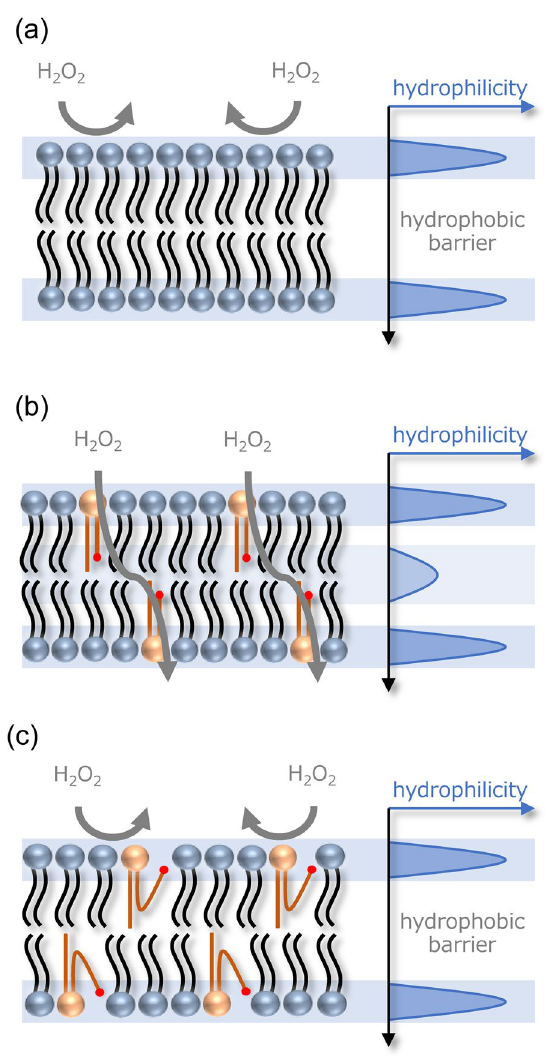
Figure 3. Schematic illustration of H 2 O 2 permeation through DOPC/POVPC bilayer under different molecular configurations. ( a ) DOPC bilayer without POVPC has a high hydrophobic barrier at the alkyl chain region, which inhibits the permeation of H 2 O 2 . ( b ) POVPC at 5 mol % forms a molecular configuration similar to DOPC that has nonlooped alkyl chains, which promotes the permeation of H 2 O 2 through the bilayer. ( c ) POVPC at 10 mol % forms a looped structure, which forms again high hydrophobic barrier to reduce the permeation of H 2 O 2